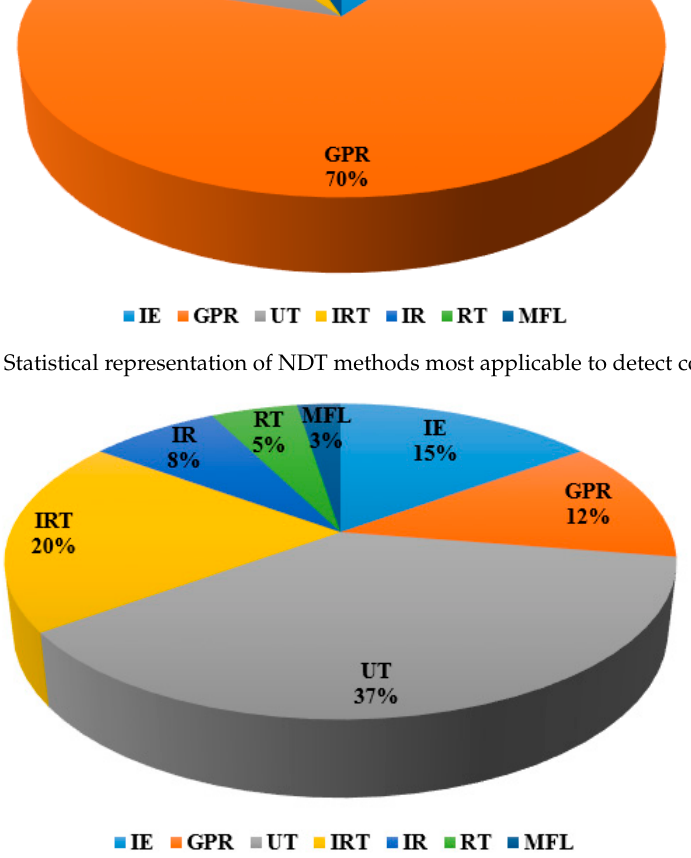
Figure 8. Statistical representation of NDT methods most applicable to detect cracks.